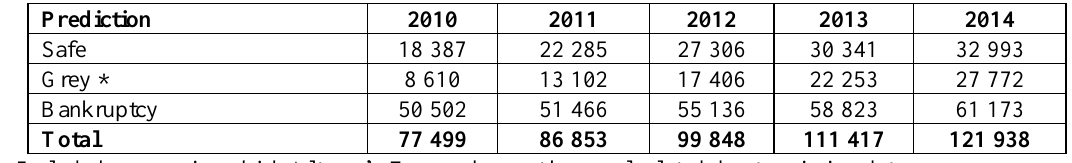
Table 2. Bankruptcy prediction based on Altman’s